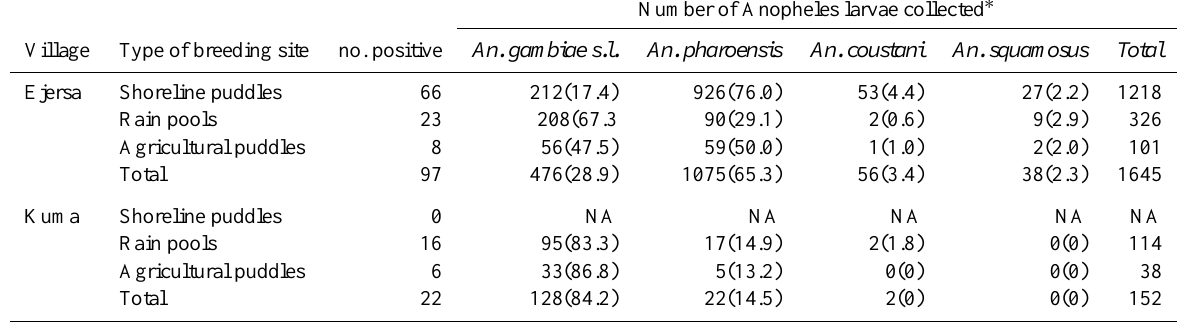
Table 1. Anopheles larval count in different types of breeding habitats in the two study sites during the study period (August– December